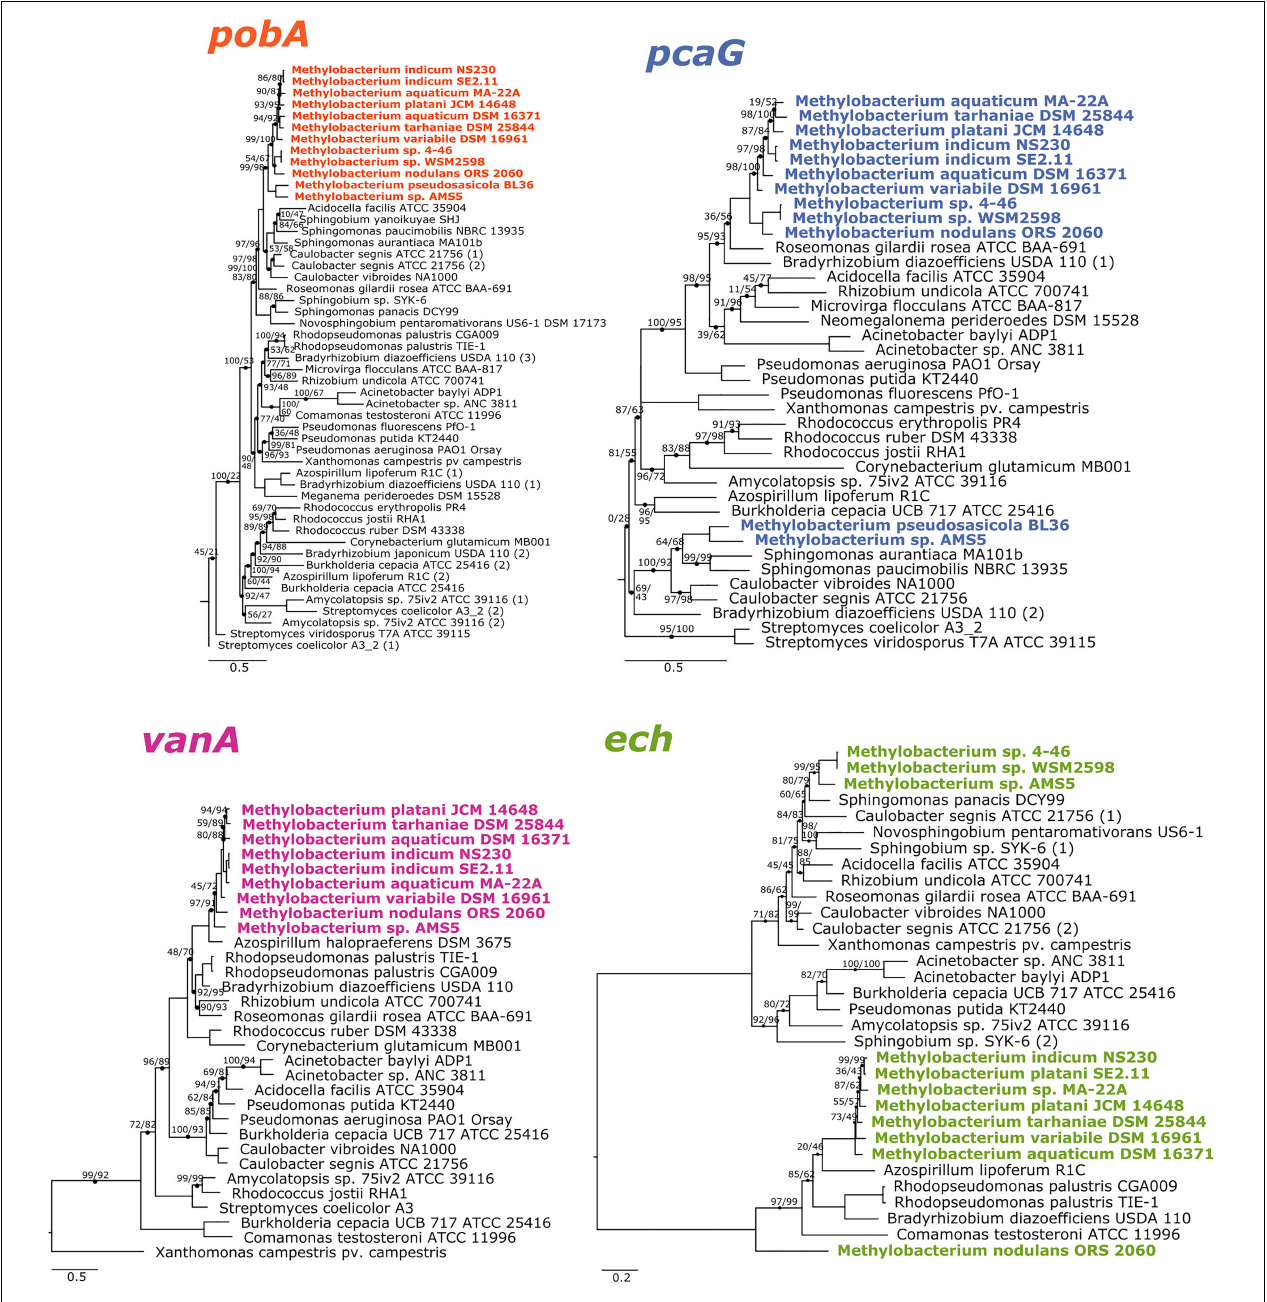
FIGURE 2 | Phylogenies of aromatic catabolism genes suggest that all four are ancestral to the M. aquaticum/nodulans clades and have been horizontally acquired by two other Methylobacterium species. For all organisms in Figure 1 , the sequences of pobA ( p -hydroxybenzoate 3-monooxygenase), pcaH (protocatechuate 3,4-dioxygenase beta subunit), vanA (vanillate monooxygenase subunit A), and ech ( trans -feruloyl-CoA hydratase/vanillin synthase) were aligned and phylogenies constructed using maximum likelihood, with homologs from archaeal organisms as outgroups (not shown). Accession numbers for all genes are given in Supplementary Tables 1, 2 . Branch labels indicate bootstrap support. Comparison of these phylogenies and that in Figure 1 suggest that all four genes are restricted to and prevalent in the M. aquaticum and M. nodulans clades, with a few losses ( vanA by Methylobacterium sp. 4–46 and WSM2598) and some gains by horizontal gene transfer (in M. pseudosasiacola and Methylobacterium sp.